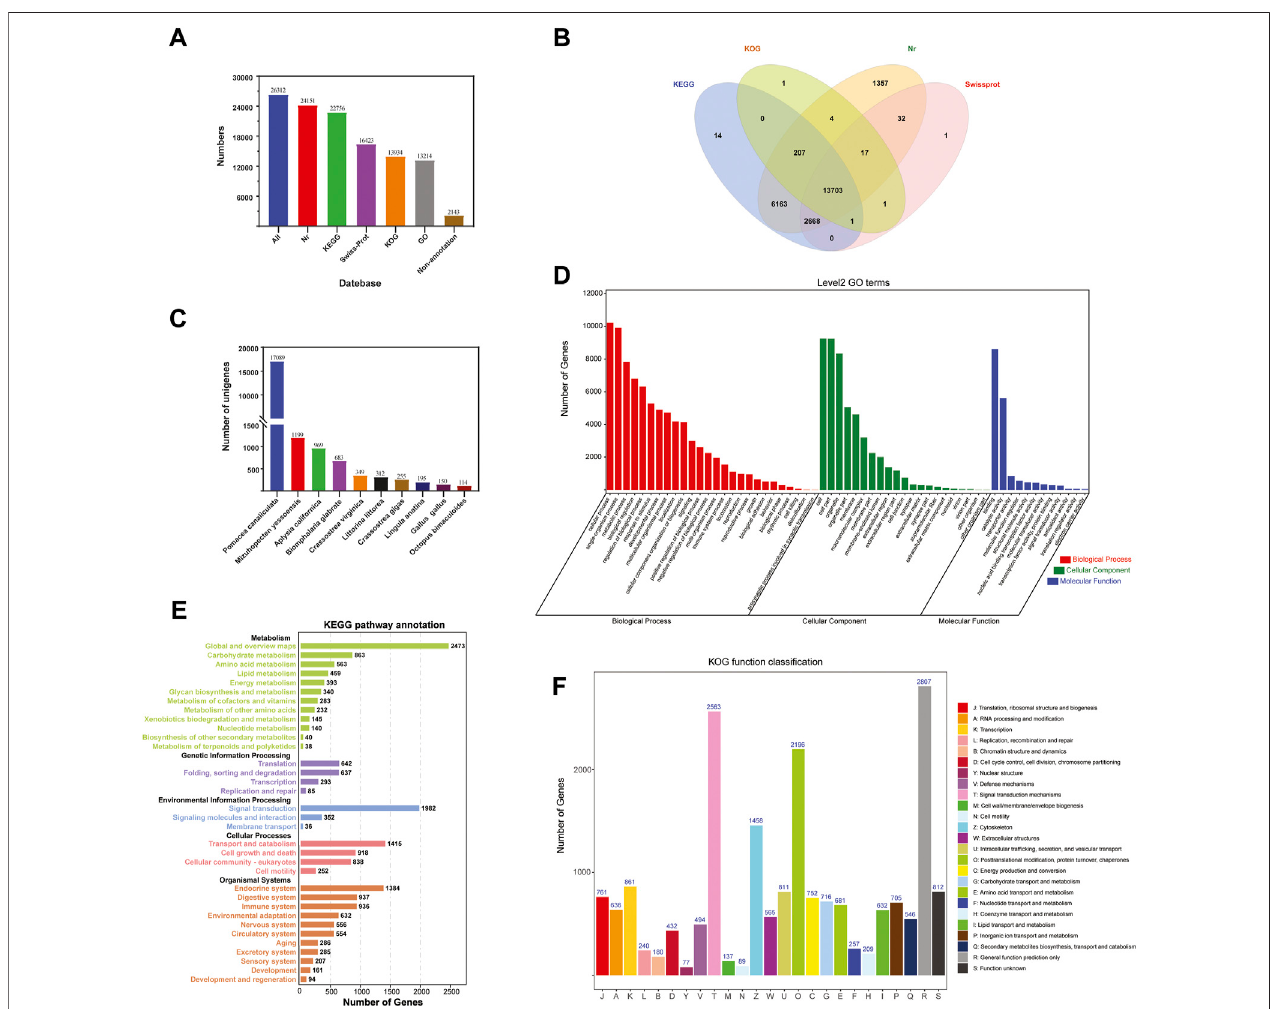
FIGURE2| Functional annotationof Cipangopaludinachinensis . (A) Statisticsofthetranscriptsannotated indifferentdatabases. (B) Venndiagramofannotations intheNR,GO,KEGG,KOG, andSwiss-Protdatabases. (C) Distribution ofthetop10specieswithmatchedtranscriptsintheNRdatabase. (D) DistributionofGOterms for all annotated transcripts in the biological process, cellular component, and molecular function ontologies. (E) KEGG pathways enriched in the transcripts. (F) COG categories of the transcripts.